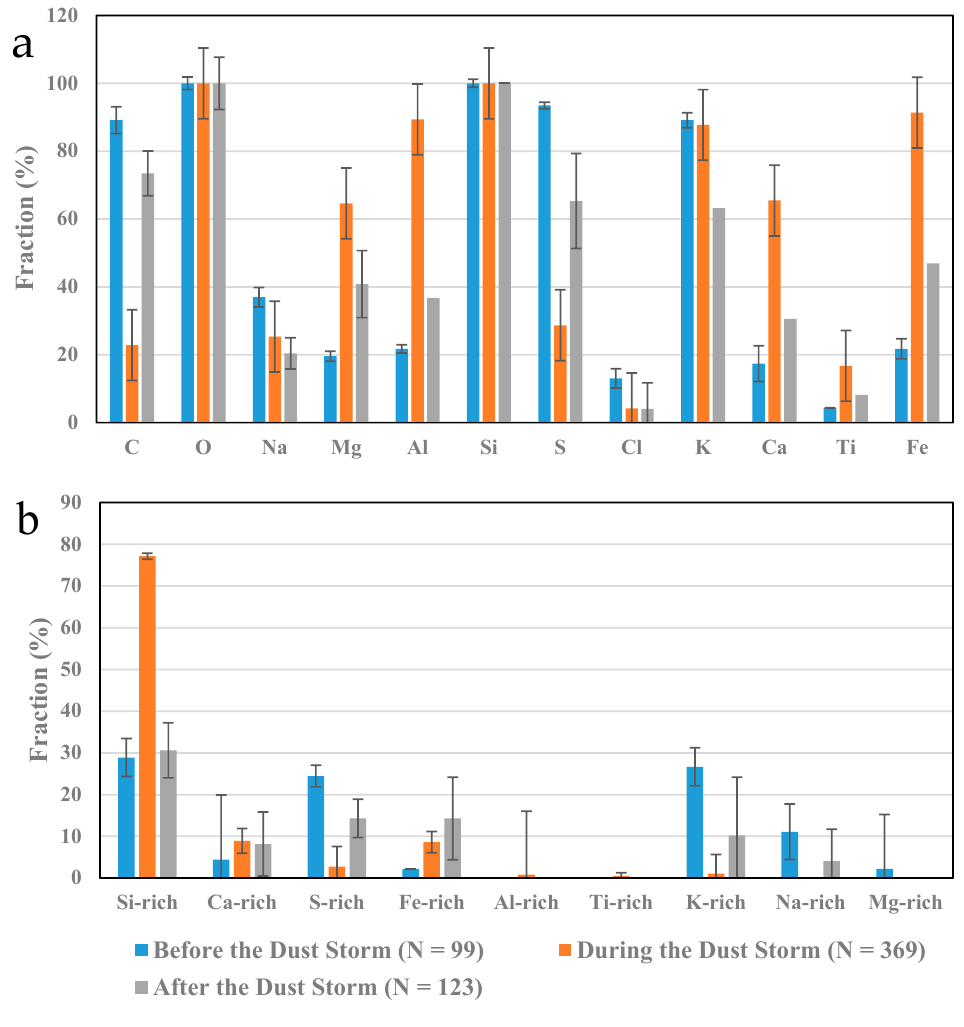
Figure 8. The relative number percentages of particles containing different elements and types in different stages of the dust storm. N represents the number of analyzed